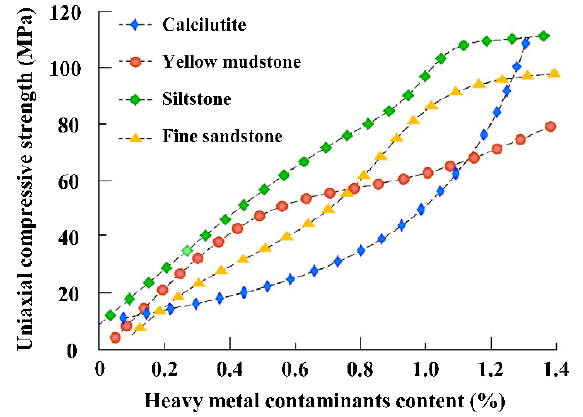
Fig. 2. The relationship between compressive strength and heavy metal